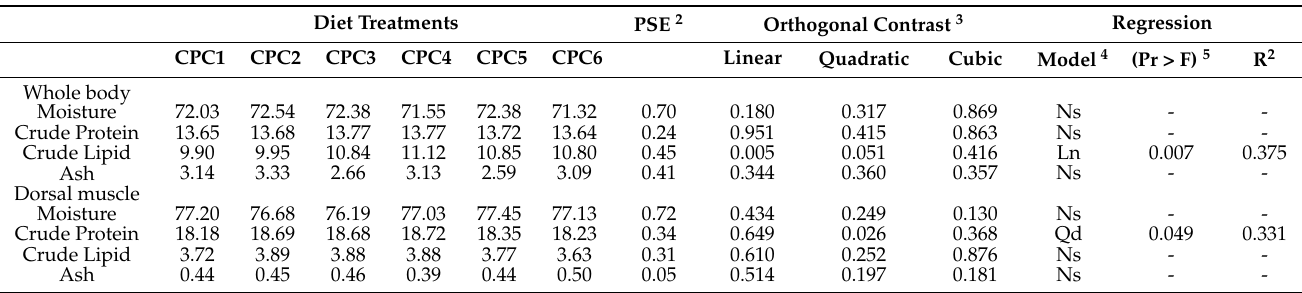
Table 4. Effects of dietary protein levels on the body and dorsal muscle proximate composition of grass carp (% fresh weight) 1 .